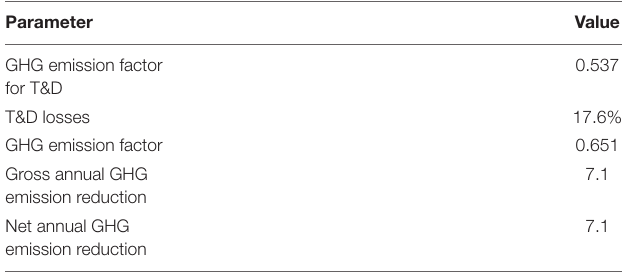
TABLE 6 | Analysis of greenhouse gas emissions. TABLE 7 | Results of the economic analysis based on method 1.